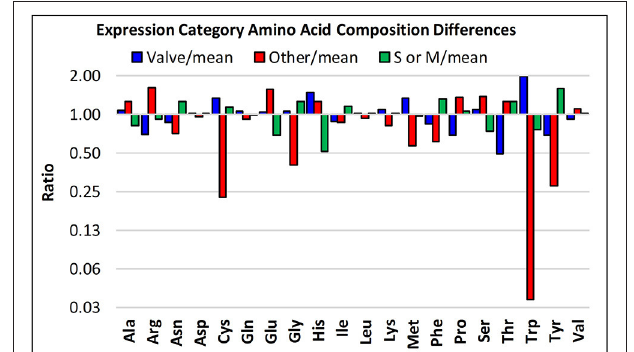
FIGURE 11 | Amino acid enrichments based on expression response category. The ratios of the abundances of particular amino acids are plotted, comparing three of the different transcript expression patterns defined in Figure 9 , specifically, valve, S or M phase, and